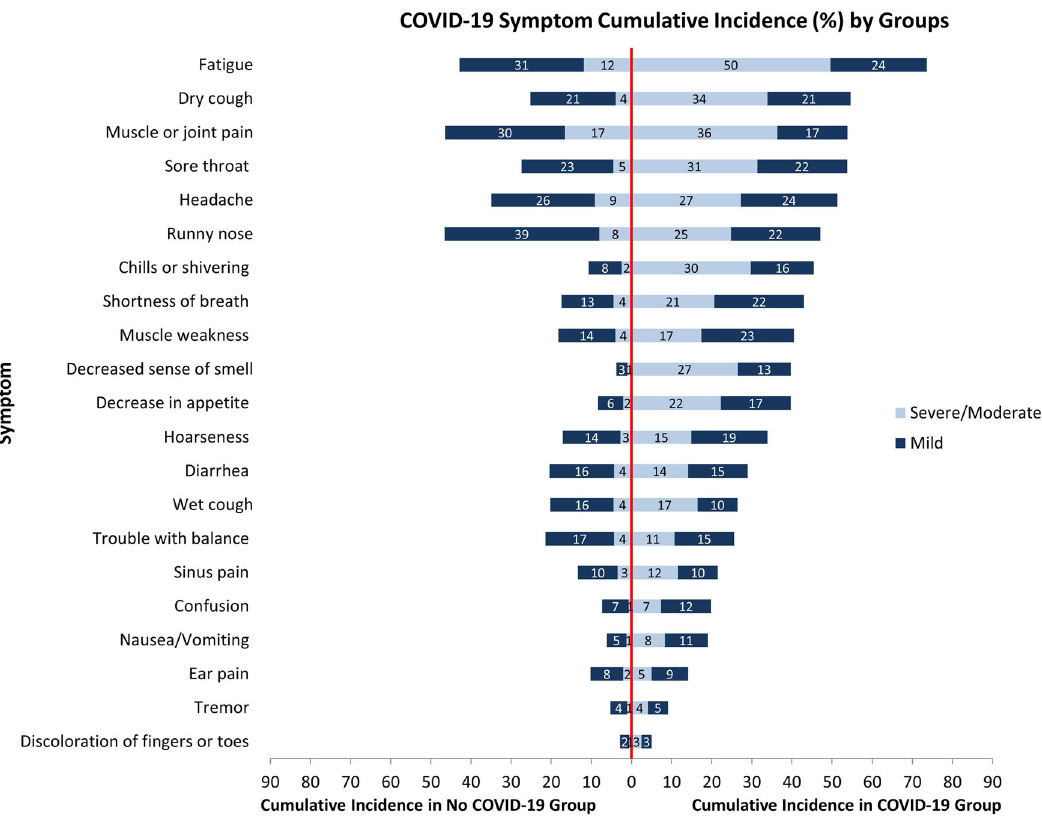
Fig. 1 Cumulative incidence of mild and moderate/severe symptoms. Cumulative incidence percent of mild (dark blue) and moderate/severe (light blue) symptoms since March 2020 reported by CLSA COVID-19 study participant who had COVID-19 ( n = 121) and who did not have COVID-19 ( n = 23,636). Data to reproduce this fi gure are included in Supplementary Data